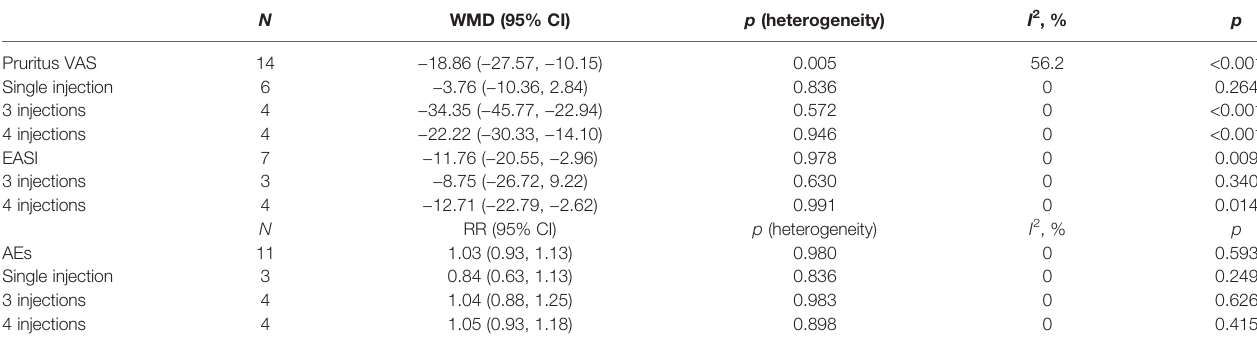
TABLE 2 | Combined results of the subgroup analyses.